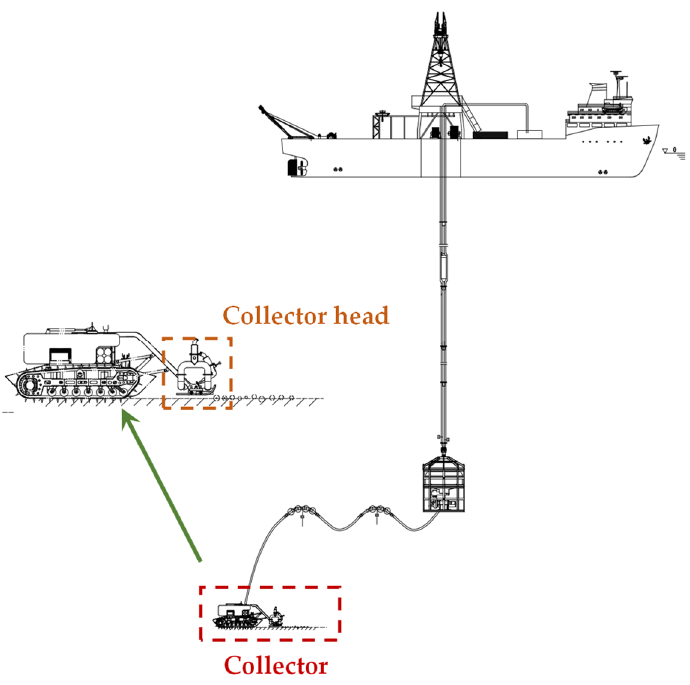
Figure 1. Schematic of a deep-sea exploitation system [2].